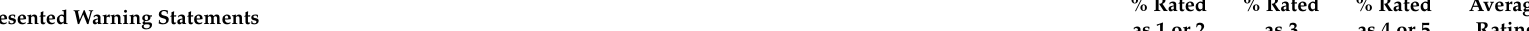
% Rated % Rated % Rated Average as 1 or 2 as 3 as 4 or 5